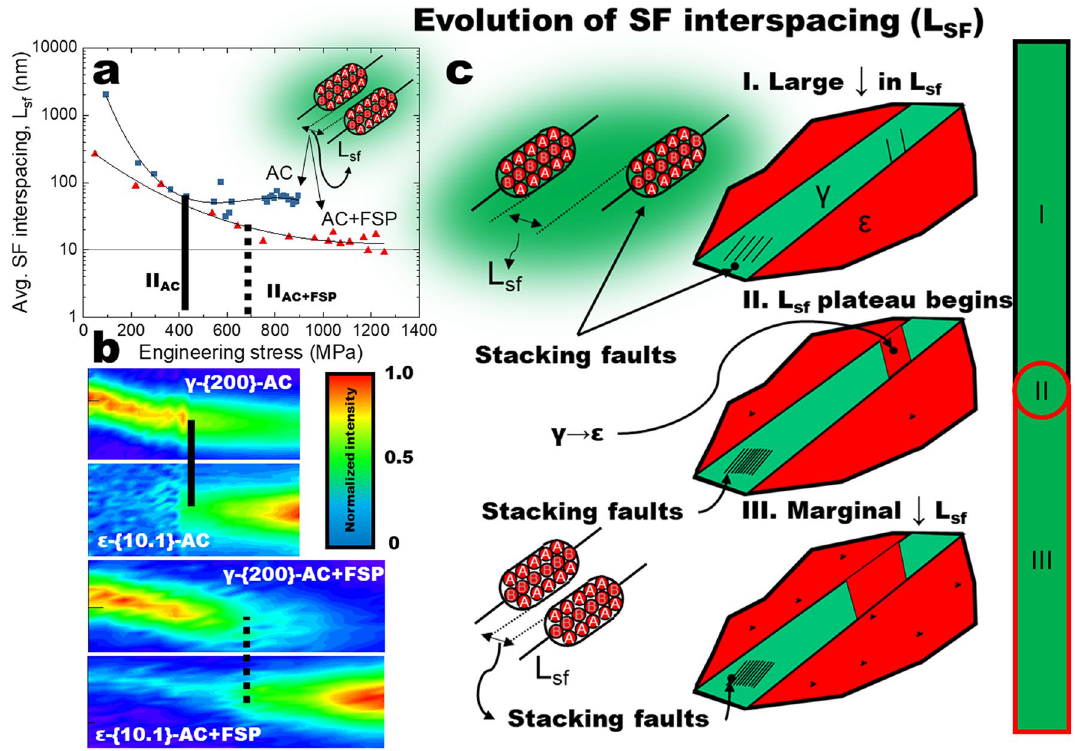
Figure 3. Mechanism of cooperative SF strengthening and transformation. ( a ) In-situ measurement of stacking fault interspacing, L sf , as a function of engineering stress. ( b ) Intensity changes indicating transformation in the as-cast (AC) and friction stir processed (AC + FSP) conditions by decrease in the γ-f.c.c. {200} intensity and an increase in the ε-h.c.p. {10.1}. ( c ) Schematic representation of SF and transformation behavior during tensile deformation. In stage I the initial SF interspacings are relatively large, L sf > 100 nm for both conditions. As tensile deformation continues to stage II (initiation marked by solid (AC) or dotted (AC + FSP) lines the decrease in L sf slows indicated by the change in slope between stages I and II. Subsequently, stage III is characterized by a relatively constant value of L sf